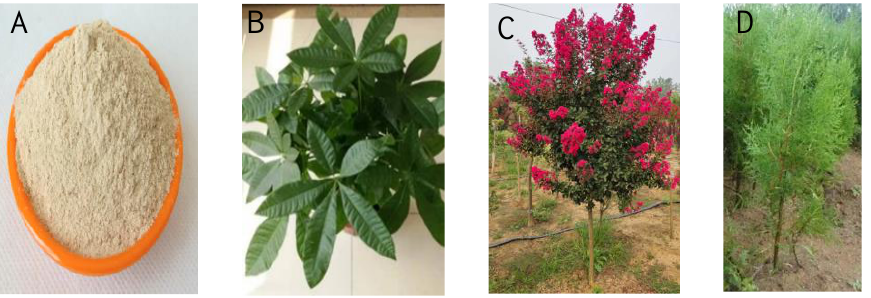
Figure 1. Photographs of the experimental materials used in the study. ( A ) Populus L. powder. ( B ) Pachira glabra Pasq . ( C ) Lagerstroemia indica L. ( D ) Juniperus virginiana Linnaeus .